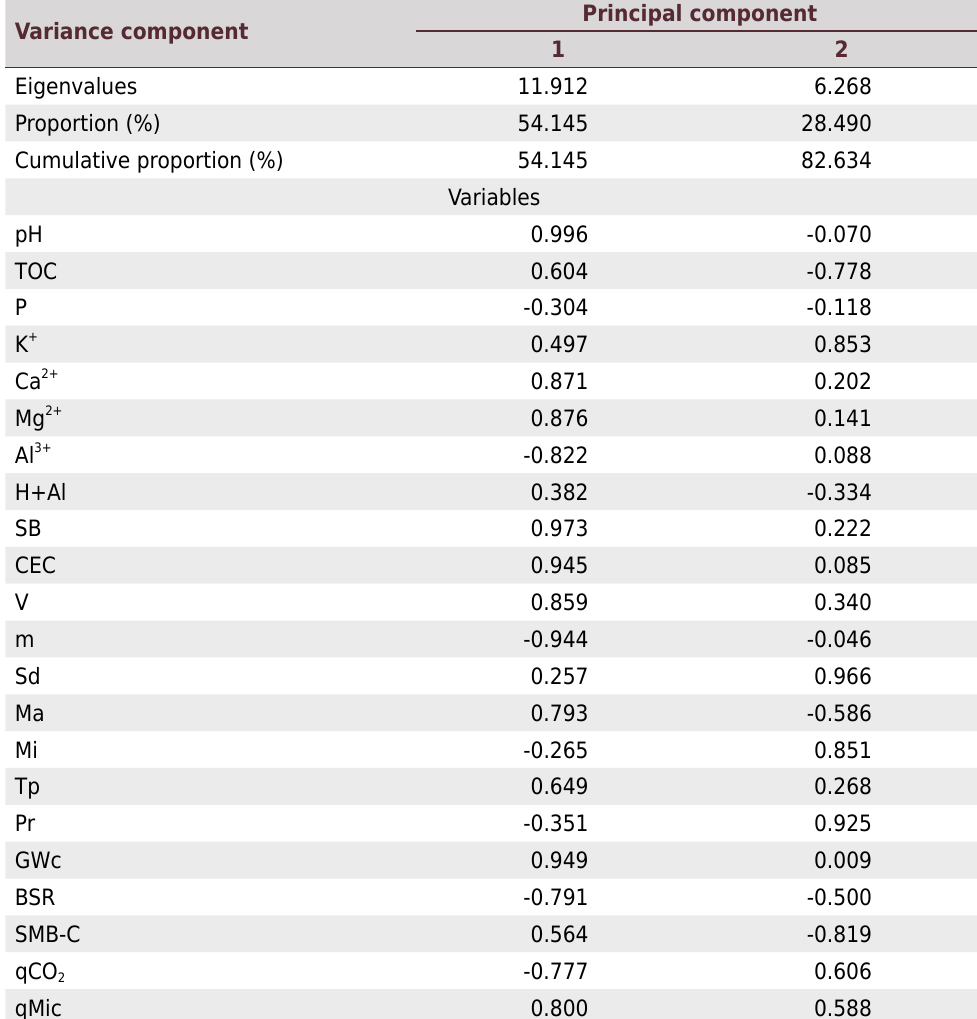
Table 6. Weight coefficients (eigenvectors), eigenvalues, variance explained, correlation of variables by each principal component (PC1 and PC2) of the different soil properties for